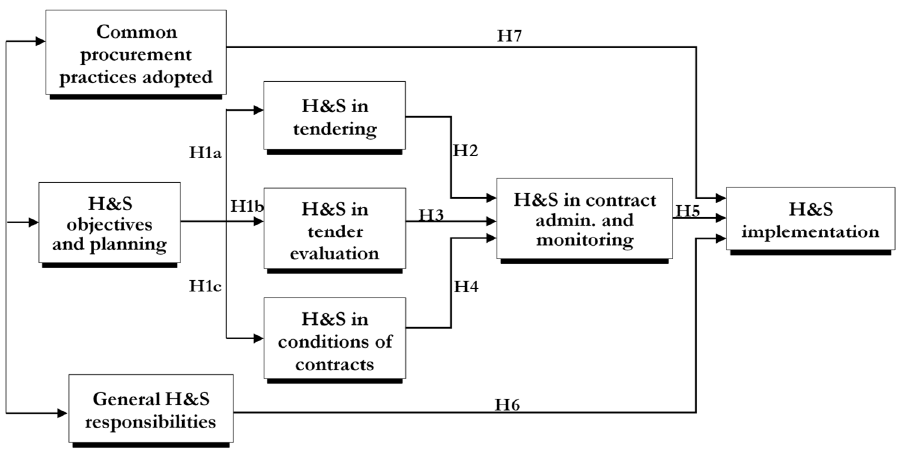
Figure 1. Theoretical model for considering H&S in construction procurement.